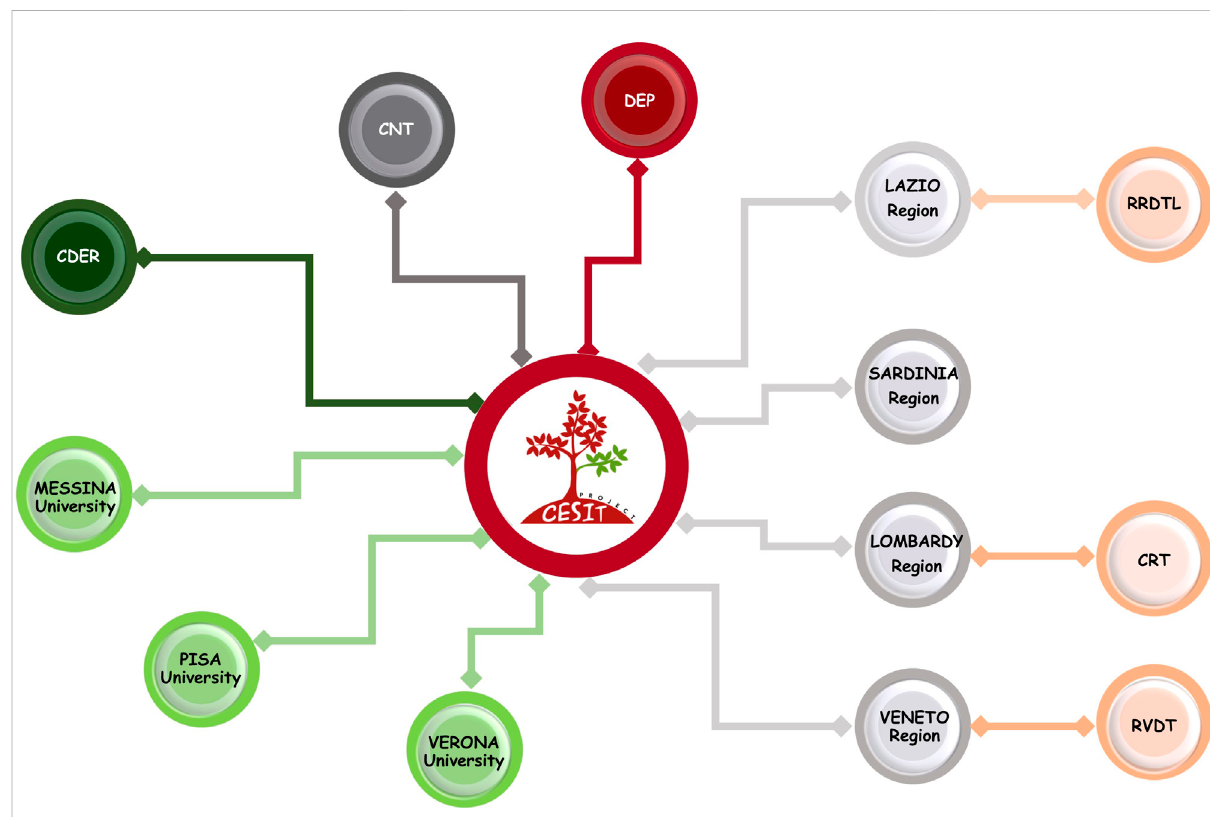
FIGURE 1 CESIT research network: participants and organization. Note. DEP: Department of Epidemiology, Lazio region; RRDTL: Lazio regional dialysis and transplant register; RVDT: Veneto regional dialysis and transplant register; CRT: Lombardy regional transplant center; CNT: National Transplant Centre; CDER: National Centre for Drug Research and